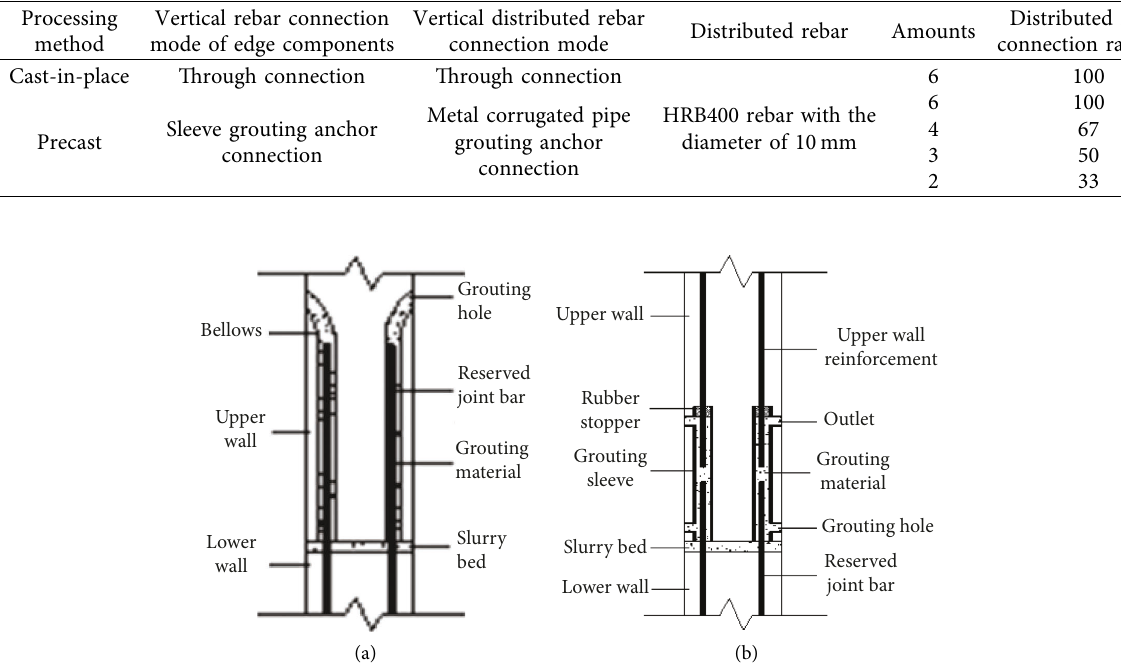
Figure 3: Bolt connection form of specimen. (a) Bellows grout anchor connection. (b) Sleeve grout anchor connection.